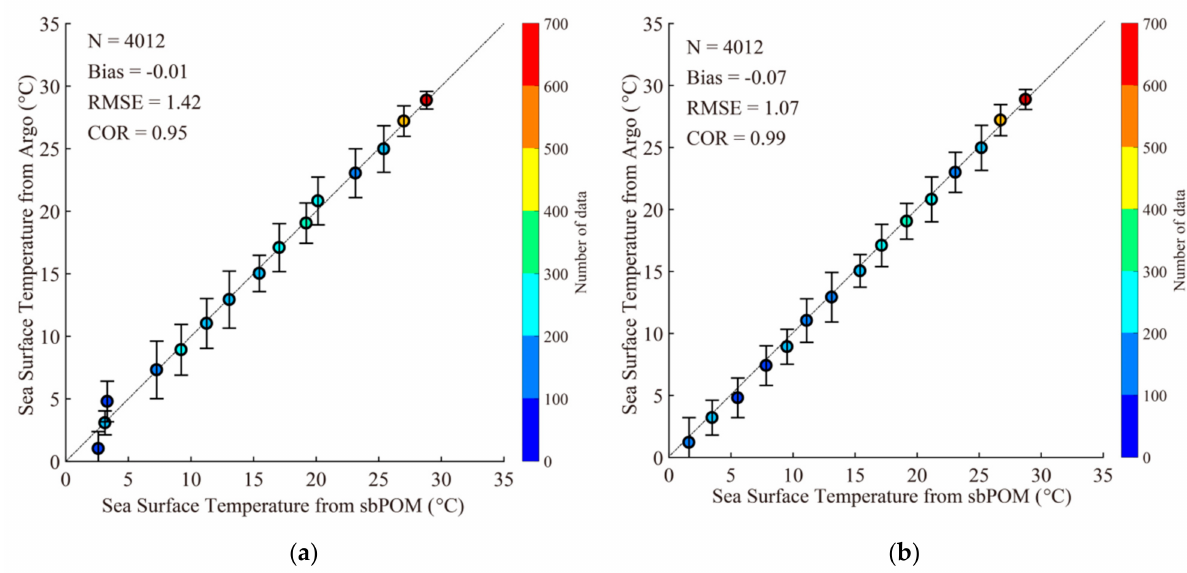
Figure 7. Comparisons of the SSTs from Argos with SSTs simulated using the sbPOM for 2 ◦ C bins between 0 and 30 ◦ C during the period 19–30 August 2012. ( a ) Not including the four effects induced by typhoon waves. ( b ) Including the four effects induced by typhoon waves.